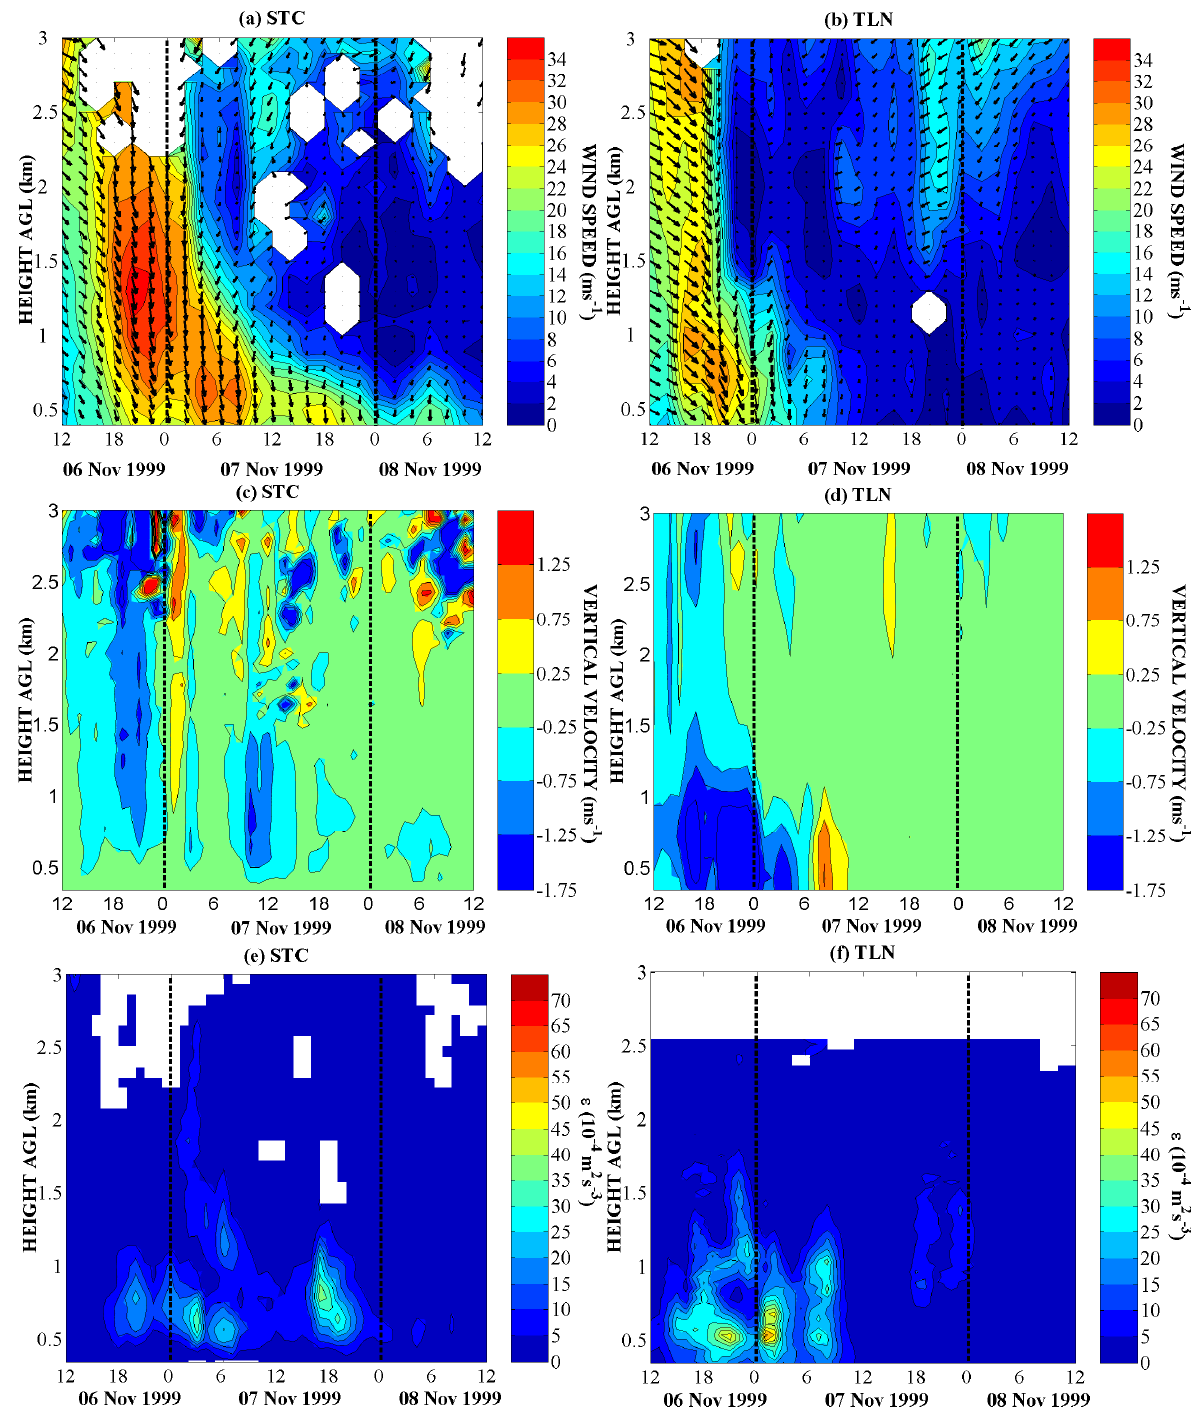
Fig. 3. Time-height diagrams of UHF-radar data obtained during the 6–8 November 1999 Mistral event (from the MAP Special Observing Period) above STC ( a , c , e ) and TLN ( b , d , f ) . The vertical dotted lines indicate 00:00 UTC. (a) and (b): horizontal wind-vectors. The wind speed values are shown using a color code, whereas the wind directions are indicated by the superimposed arrows (a northerly wind corresponds to an arrow toward the bottom). The arrow lengths are proportional to the speed values. (c) and (d): vertical velocity values. (e) and (f): turbulent dissipation rate